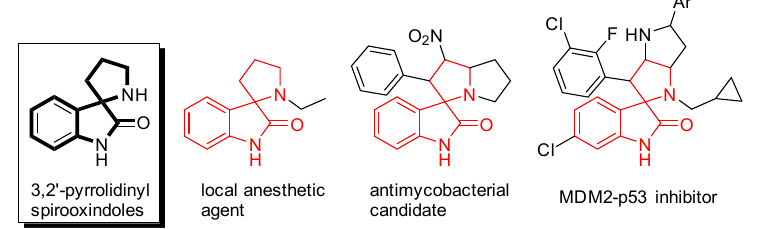
Figure 1. Biologically active 3,2 ′ -pyrrolidinyl spirooxindole derivatives